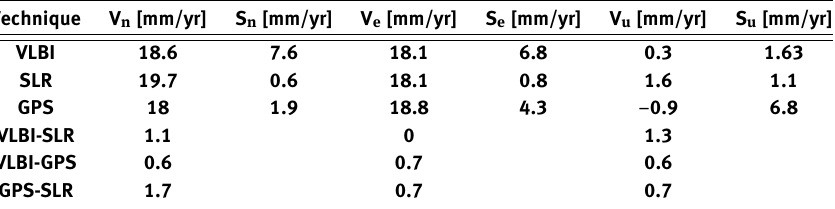
Fig. 6. Time series for the GPS station HRAO, the SLR station MOBLAS-6 and the 26 m VLBI telescope. The coordinates are not in the same coordinate system, they are arbitrary plotted to illustrate velocity trend for each technique. Table 1. Comparison of VLBI, SLR and GPS velocity solutions (V n , V e and V u ) with the associated standard deviation (S n , S e and S u ) and their